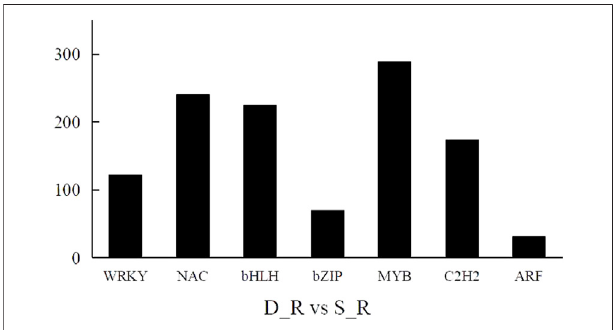
FIGURE 9 | Differentially expressed transcription factor results.